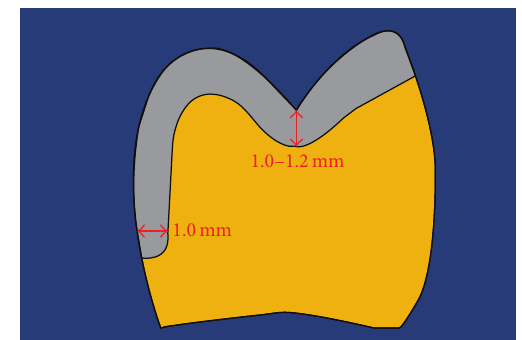
Figure 2: Minimum material thickness recommended for all- ceramic partial crowns fabricated from zirconia-reinforced lithium silicate (ZLS)